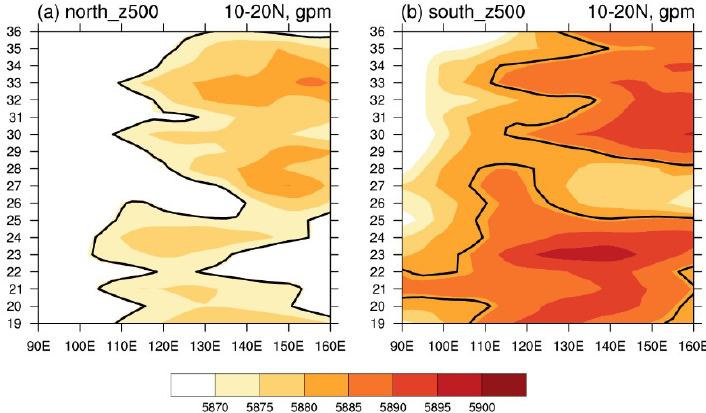
Figure 12. Hovmöller diagram of composite geopotential height at 500 hPa (shading; gpm) along 10 ◦ –20 ◦ N from Pentad 19 to Pentad 36 in the North ( left ) and South ( right ) track cases. The average geopotential height in the North ( a , 5870.49 gpm) and South ( b , 5883.98 gpm) track cases over the SCS (10 ◦ –20 ◦ N, 110 ◦ –120 ◦ N) during Pentad 19 to Pentad 36 are highlighted by thick contours, which indicate the Western ridge of the WNPSH.